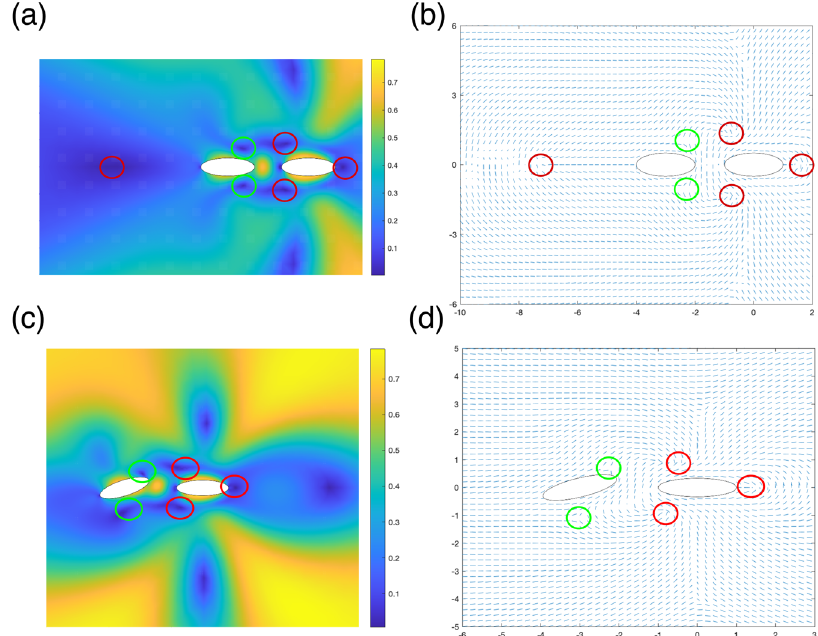
Fig. 6 Two swimmers in VELC. Two pushers ( β = − 2) with planar anchoring ( W = 0.5) swim in VELC. Coupling parameter χ = − 0.03. Topological defects generated by the swimmer are encircled. Red and green circles are correspondingly “ + 1/2 ” and “ − 1/2 ” defects. a Scalar order parameter q ( x ) around the swimmer when two swimmers are launched with same initial orientation α = 0. b Corresponding director fi eld n ( x ) of ( a ). c Scalar order parameter q ( x ) around the swimmer when two swimmers are launched with different initial orientation, α = 0 for the leading one and α ¼ π following one. d Corresponding director fi eld n ( x ) of ( c